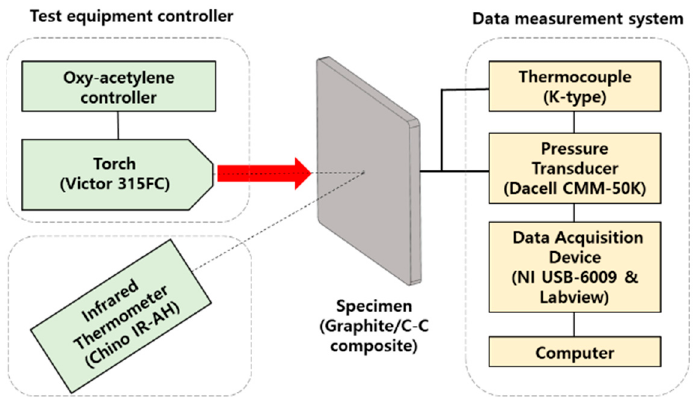
Figure 4. Schematic diagram of oxy-acetylene torch test equipment.